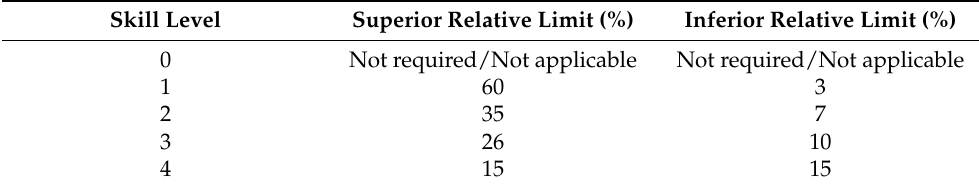
Table 3. Example of superior and inferior relative limits.